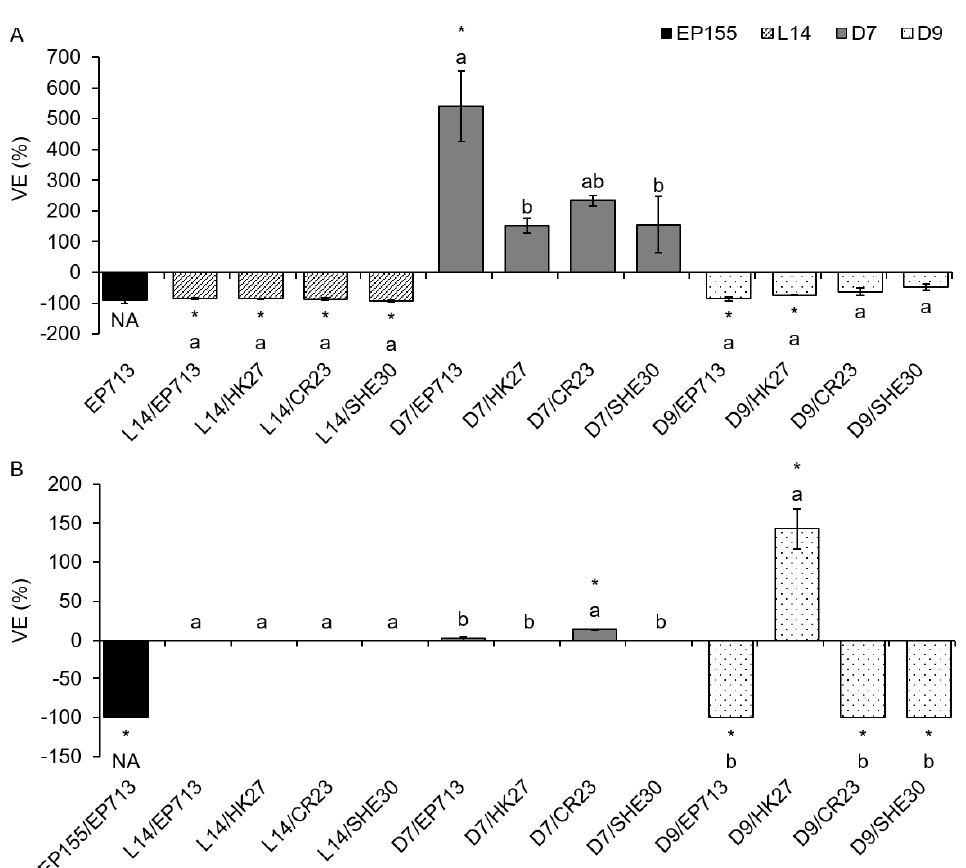
Figure 3. Effect of virus infection on extracellular laccase (ecLAC) activity of four Cryphonectria parasitica isolates when grown on liquid media ( A ) potato dextrose broth and ( B ) malt extract. Results are represented as mean virus effect (VE) value (difference between each triplicate measurement of HV isolat’ LAC activity and the mean of the corresponding isogenic VIR isolate LAC activity, given as a percentage of the performances of the VIR isolate) ± standard error. An asterisk (*) denotes virus-infected cultures with ecLAC values significantly different from the corresponding VIR fungal isolate. Letters denote statistical differences between different virus strains infecting the same fungal isolate at p < 0.05. NA = not applicable to the statistical comparison of virus strains due to only one fungus/virus combination. VE in ( B ) for all L14 isolates, D7/HK27 and D7/SHE30 equaled zero, as in both VIR and HV fungi the smLAC activity equaled zero.